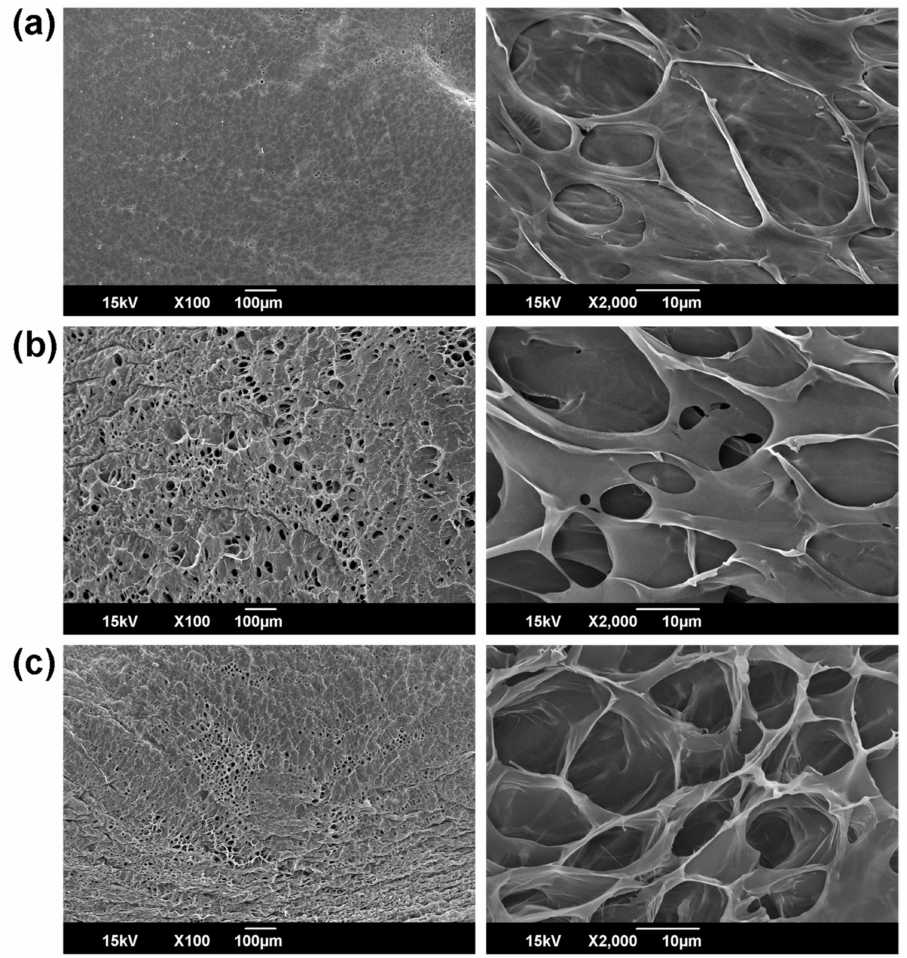
Figure 6. Scanning electron microscopic (SEM) images of surface (left side images) and the cross- section (right side images) of hydrogels. ( a ) PTHG-A, ( b ) PTHG-B, and ( c )